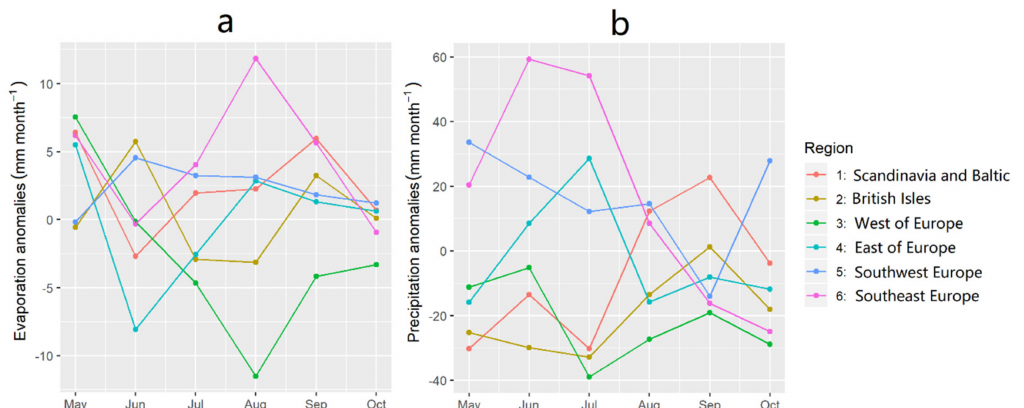
Figure 3. Region average development of ( a ) evaporation and ( b ) precipitation anomalies in 2018. The total numbers of normal and 2018 evaporation and precipitation can be found in the Supplementary Materials (Tables S1–S4). The spatial extent of the regions is shown in Figure